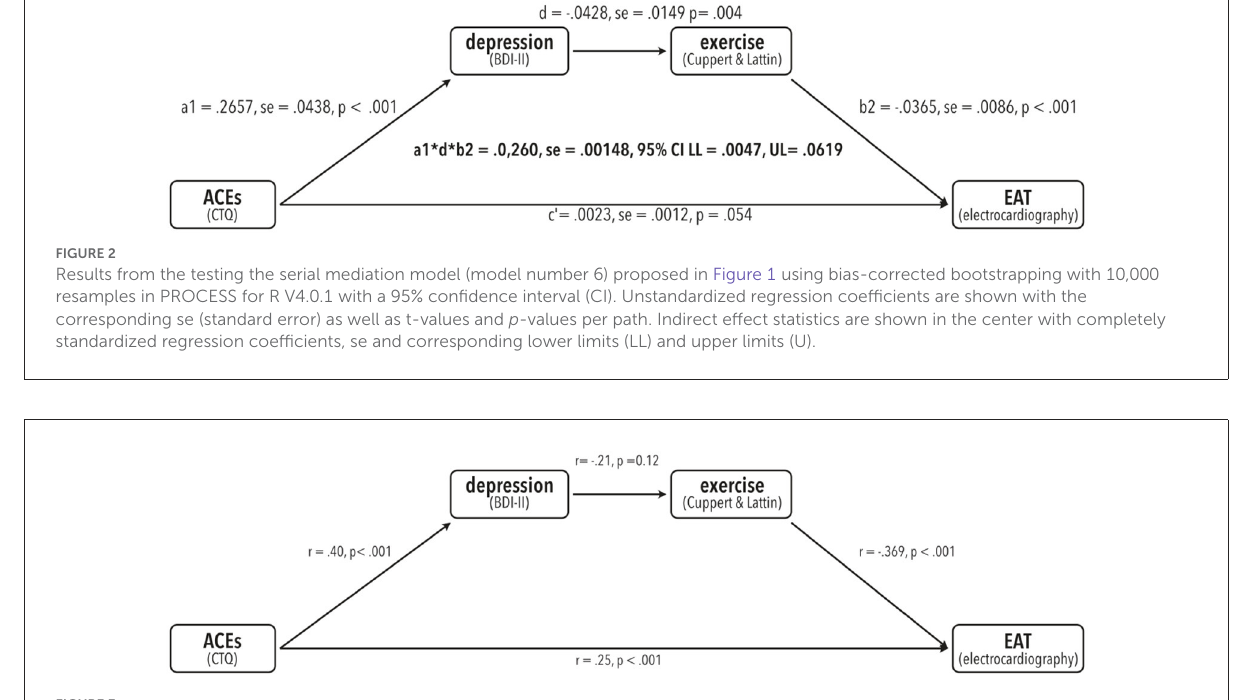
FIGURE3 Illustration of the results from single linear regression analyses from all paths present in the mediation model. Pearson’s r-values and corresponding p -values are